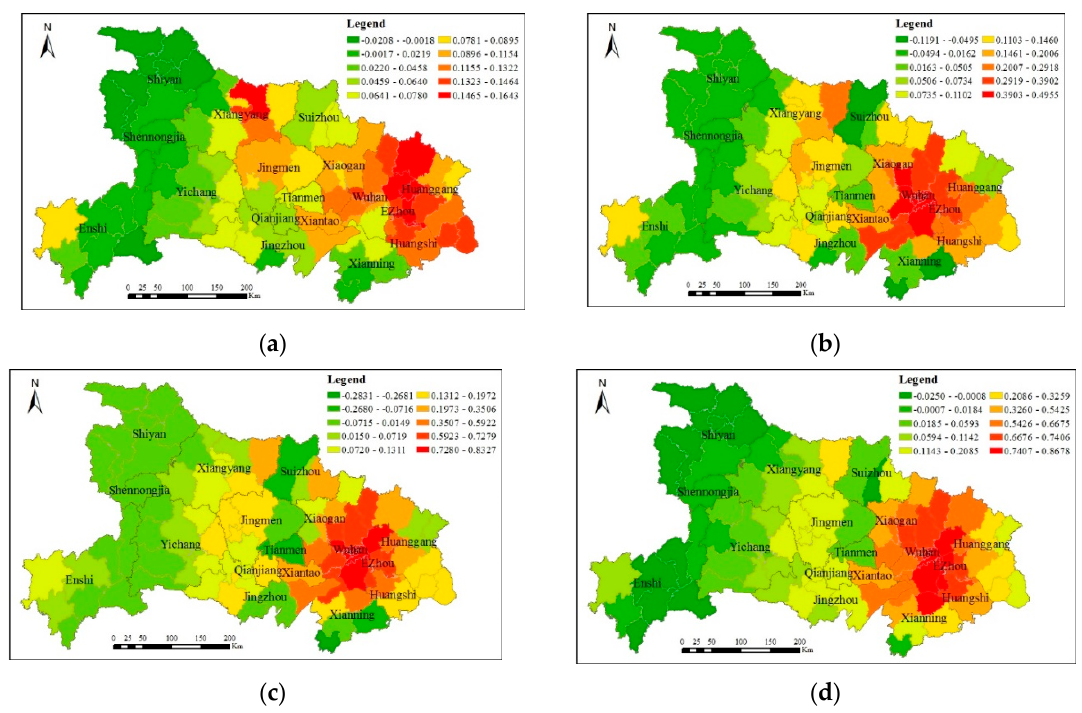
Figure 7. The spatio-temporal differentiation of the resident population: ( a ) from 11 to 18 January